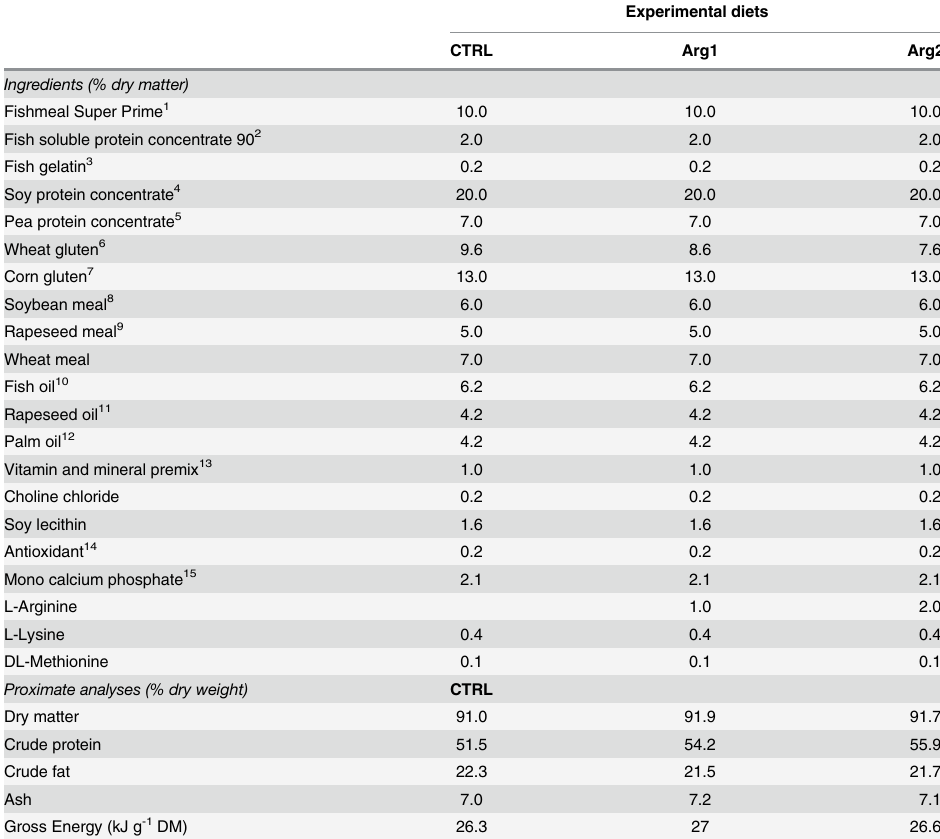
Table 1. Ingredients and proximal composition of experimental